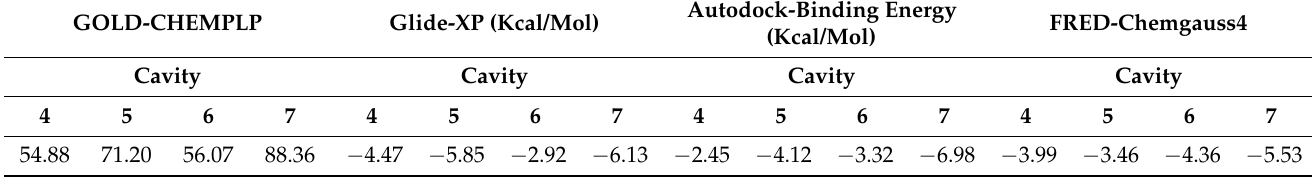
Table 1. Score values obtained using docking software GOLD, Glide, Autodock, and FRED for compound 1 against the four allosteric cavities (4, 5, 6, and 7) of GSK-3 β . GOLD-CHEMPLP